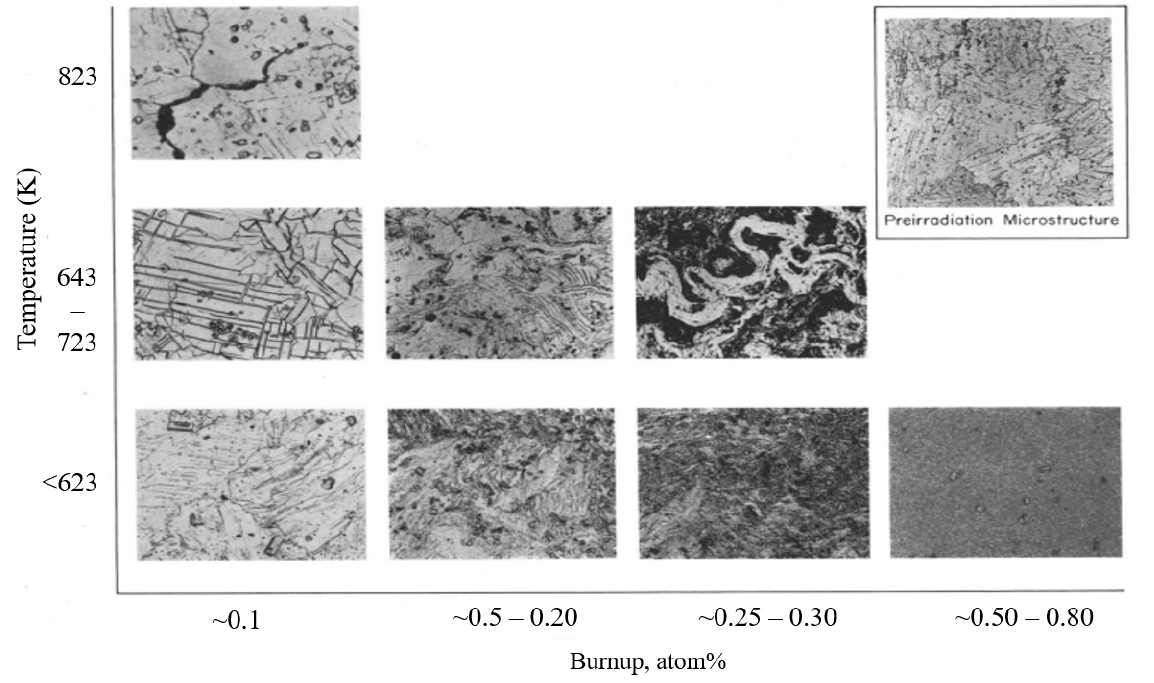
Figure 9. Microstructure evolution at different irradiation temperature and burnup (Re- Microstructure evolution at different irradiation temperature and burnup printed/adapted with permission from Ref. [48], 2022, Elsevier). (Reprinted/adapted with permission from Ref. [48], 2022,